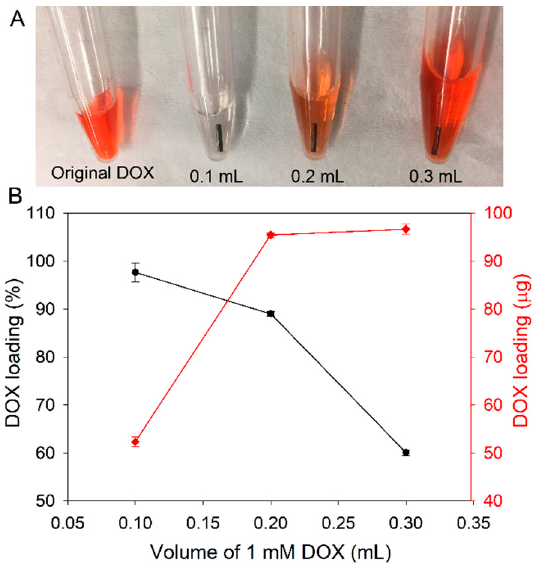
Figure 6. Loading of different volumes of 1 mM DOX on np-Au at pH 5.5. ( A ) Photographic image of original DOX (left) and after 24 h loading on np-Au from 0.1, 0.2, and 0.3 mL DOX solution. ( B ) Amount of DOX loaded on np-Au from a different volume.